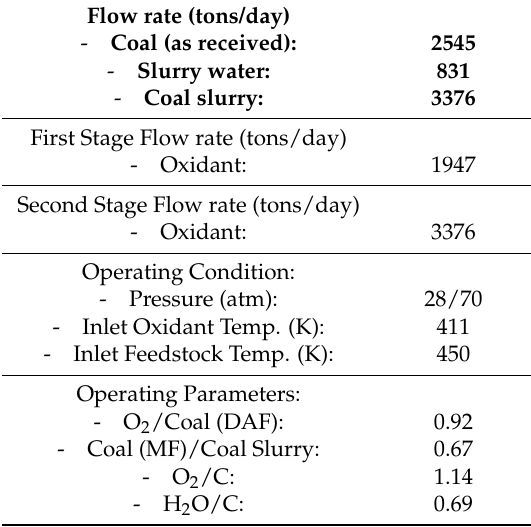
Table 4. Feedstock and operating conditions of the base case.